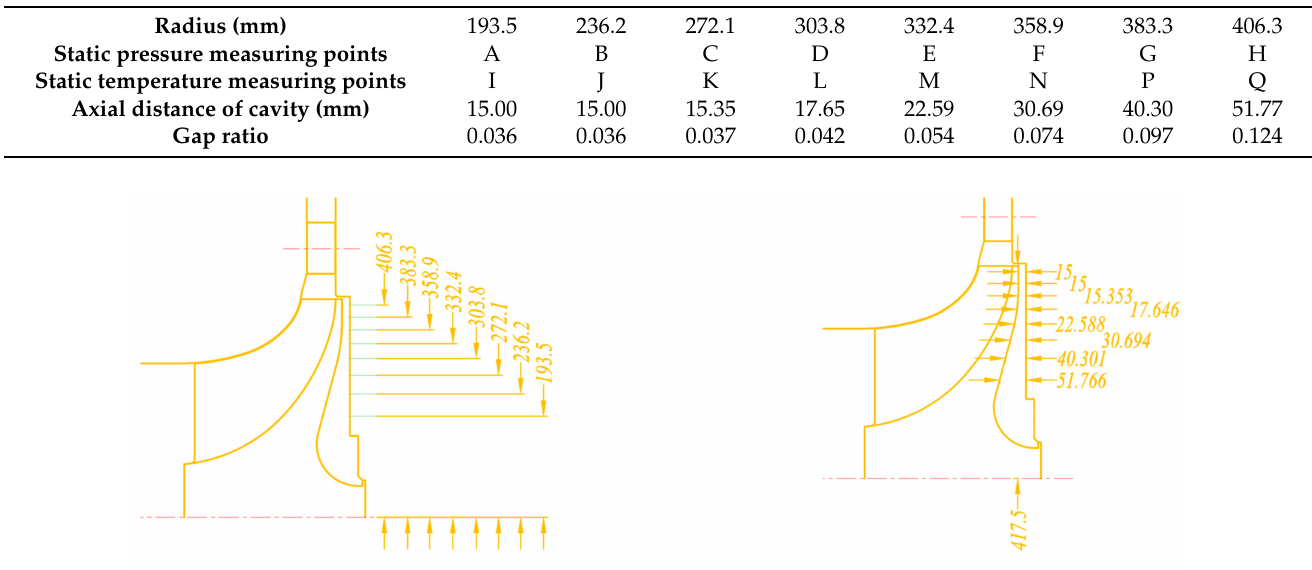
Table 2. Specific correspondence of measuring points and marked points.